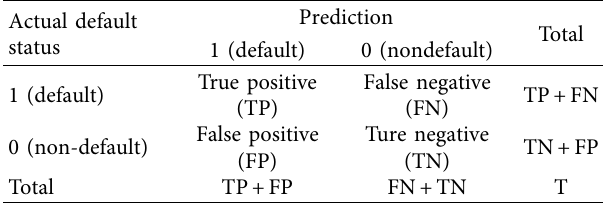
Table 1: Confusion